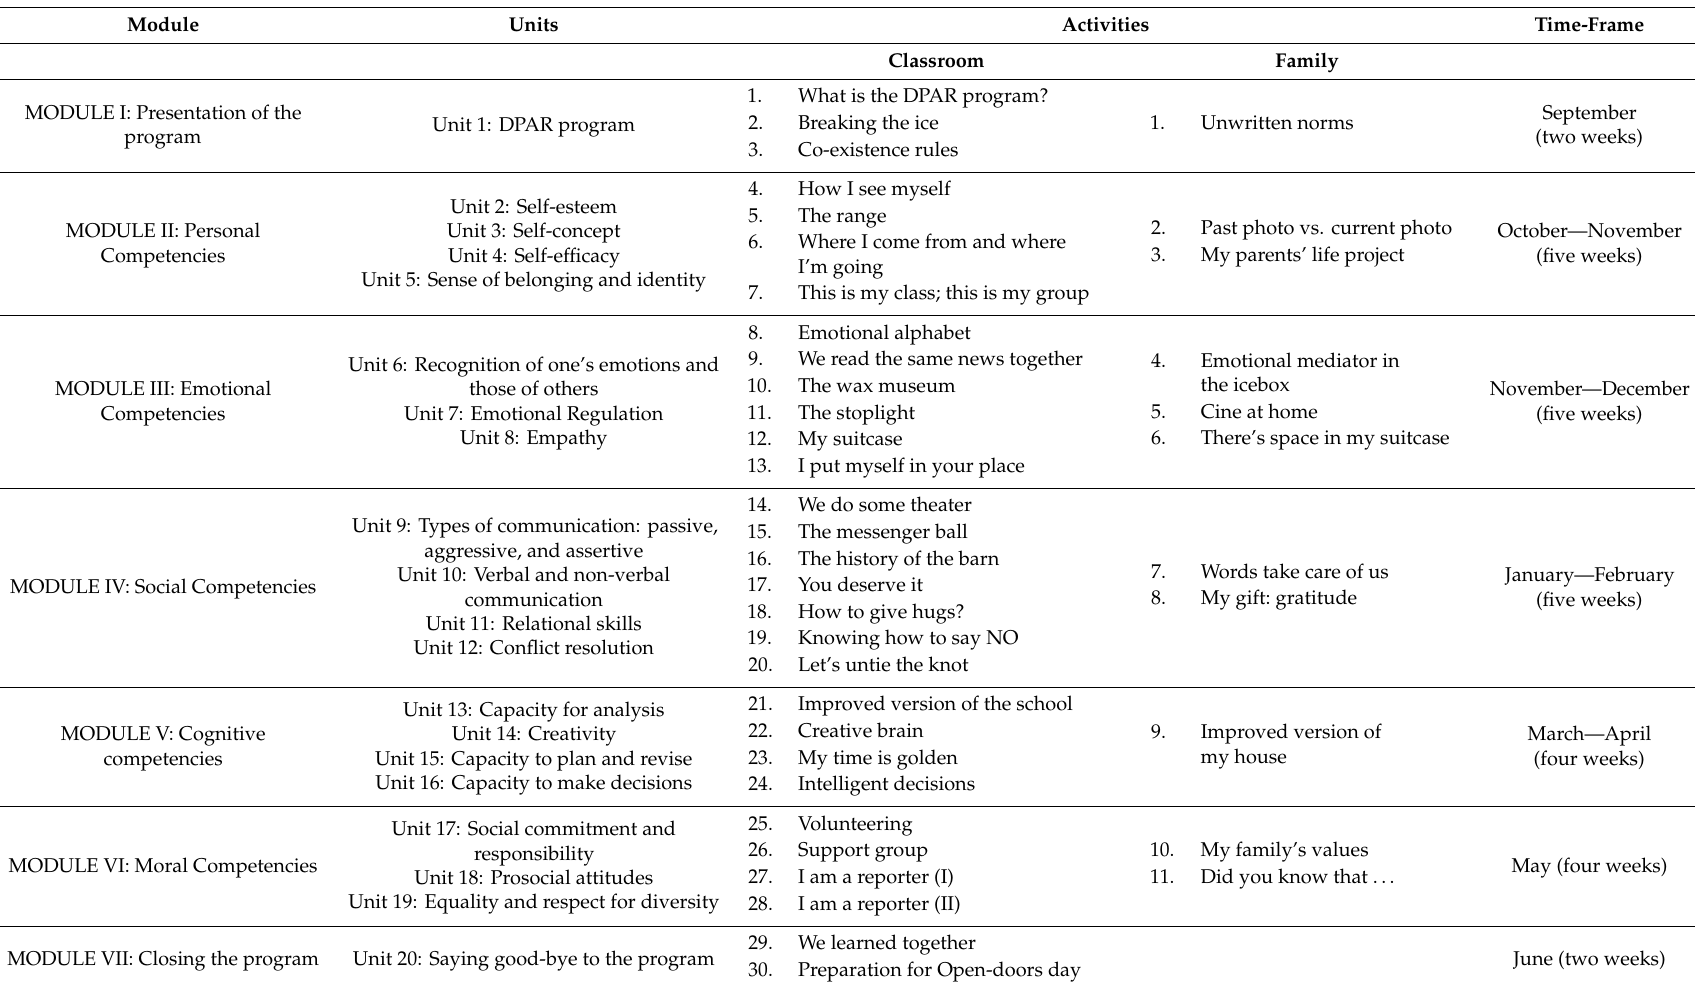
Table 3. Structure, activities, and timing of the DPAR